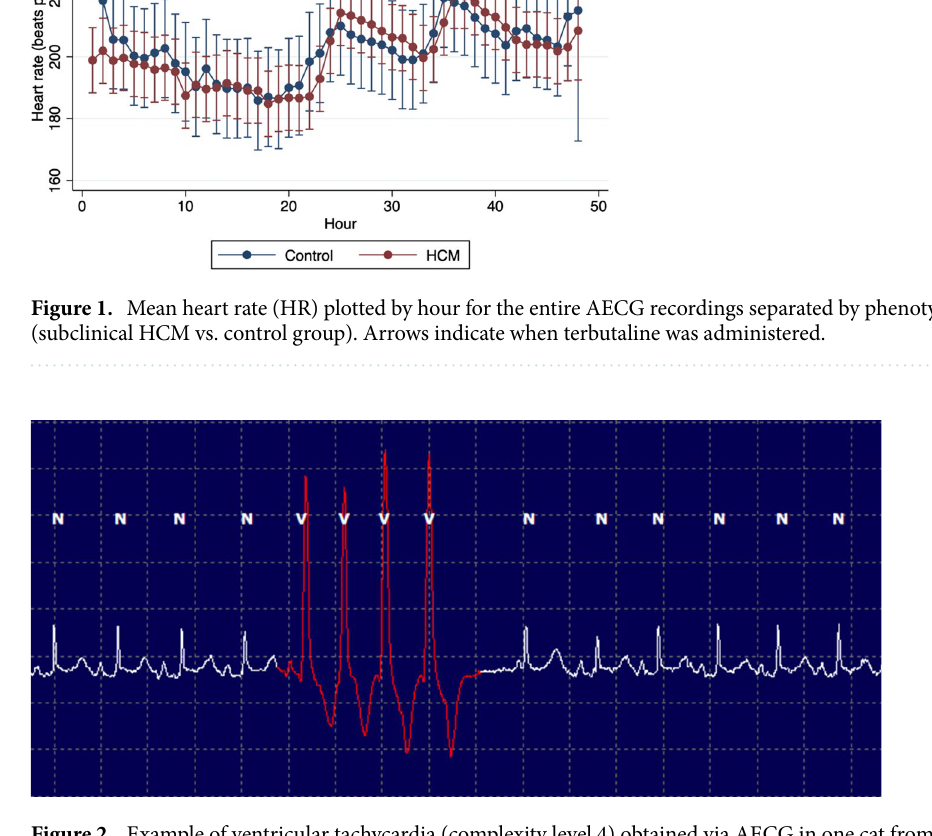
tration (p < 0.0001). There was no significant difference in the mean heart rate for cats in the HCM group versus the control group (p = 0.42). Figure 1 shows mean heart rate over the entirety of the recordings, demonstrating similar rates between the two phenotypic groups and the rise in heart rate for both groups in the stressed state. The median number of supraventricular ectopic beats over the entire recording period was 2 (IQR = 0–7) with a median complexity level of 1 (IQR = 0–1). Seventeen of the 23 cats (73.9%) had at least one supraventricular premature complex over the recording period, the majority of which were single isolated complexes. The median number of ventricular ectopic beats over the recording period was 8 beats (IQR = 2–38) with a median complex- ity level of 1 (IQR = 1–4). Twenty-one of the 23 cats (91.3%) had at least one ventricular premature complex on their ECG recording. Most cats (14/23) only experienced single ventricular premature complexes, however there were six cats (26%) that had ventricular tachycardia (four or more complexes in a row) (Fig. 2). Two of these cats were in the control group and four were in the HCM group. The frequency and complexity of ventricular and supraventricular ectopic beats between the two groups are shown in Table 3. Simple linear regression was performed for both the total number of supraventricular and ventricular ectopic beats, assessing phenotype, sex, age, mutant allele count, NTproBNP, maximal left ventricular wall thickness, and the presence or absence of left ventricular outflow tract obstruction as possible predictors. Of these vari- ables, none were significantly correlated with the total number of supraventricular ectopic beats. Only mutant allele count (genotype) was significantly correlated with the number of ventricular ectopic beats (p = 0.049; R 2 = 0.17). Using multiple linear regression to evaluate the same variables as predictors of ectopy frequency, mutant allele count was significantly correlated with the total number of both ventricular (p = 0.026; R 2 = 0.66) and supraventricular (p = 0.033; R 2 = 0.66) ectopic beats (Table 4). When comparing the number and complexity of both supraventricular and ventricular ectopic beats before and after terbutaline administration there were no significant differences. Seven cats (30.4%) were noted to have a sinus arrhythmia at some point during the AECG recording. Of these, all seven cats were within the HCM phenotype group with zero cats in the control group having a sinus arrhythmia present on their recording (p = 0.06).